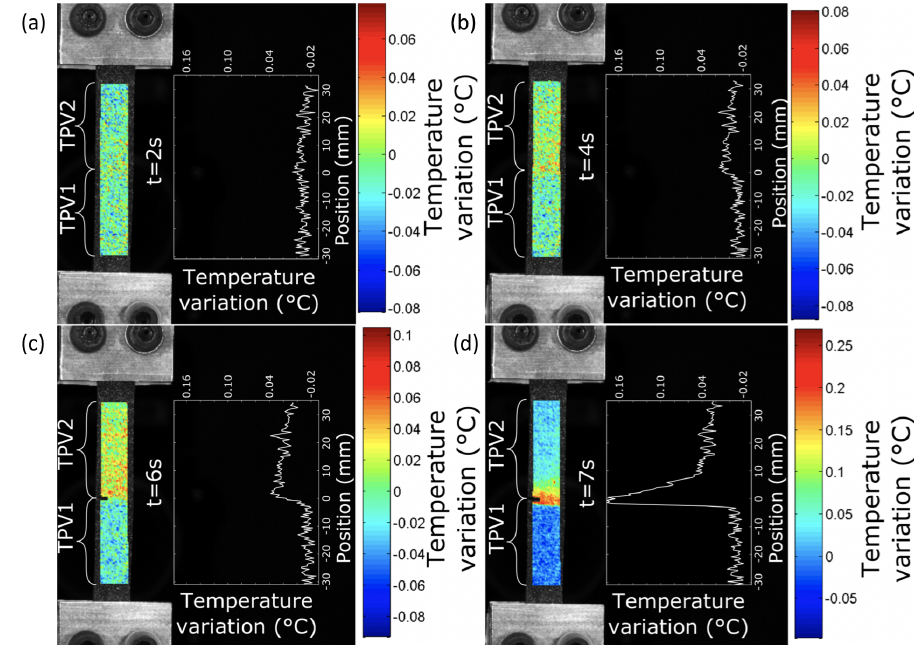
Figure 17. Temperature variation fields and the temperature variation profiles along the specimens overmoulded at 190 ◦ C. ( a ) t 1 = 2 s, ( b ) t 2 = 4 s, ( c ) t 3 = 6 s and ( d ) t 4 = 7 s.